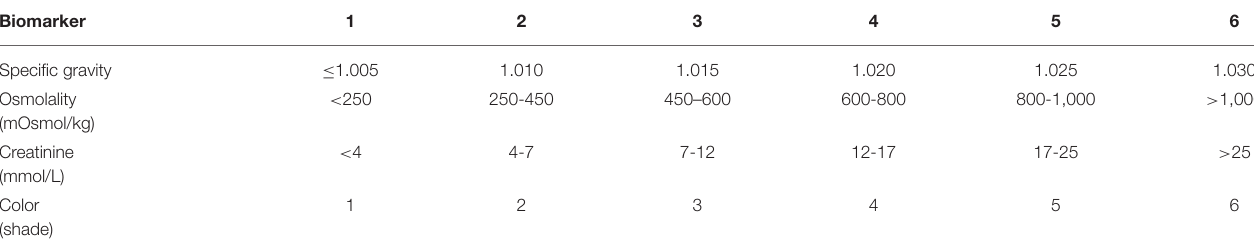
TABLE 1 | Scheme for calculating the Fluid Retention Index (FRI), which is the mean of the scores for 4 urinary indexes of concentrated urine.